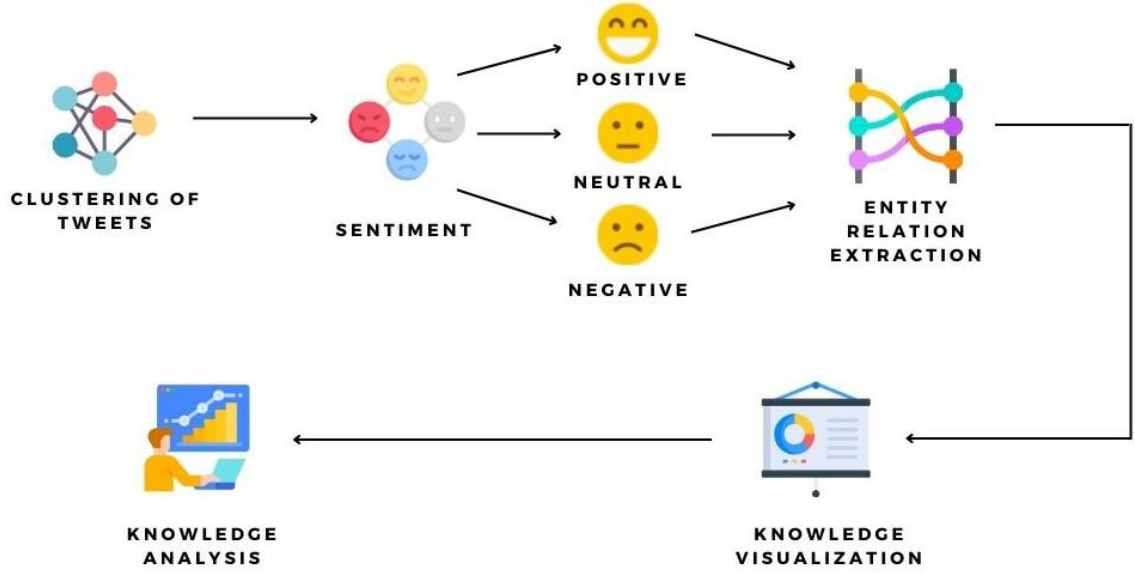
Figure 14. Experimental Flow for Result.